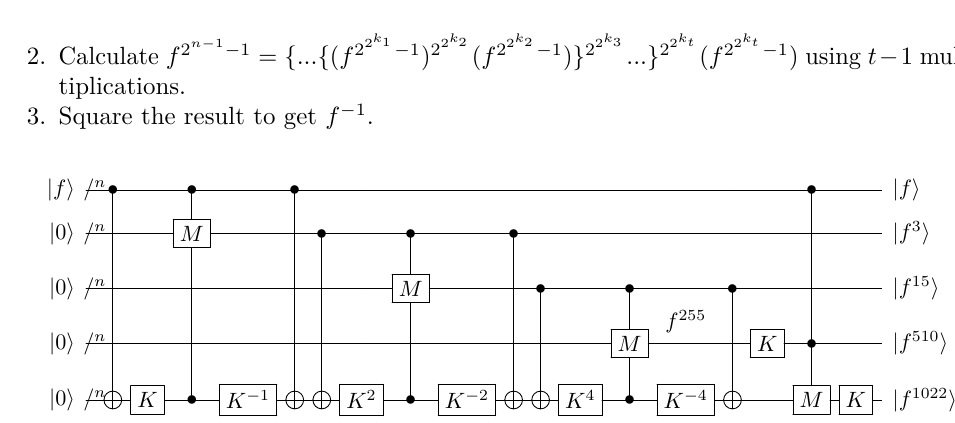
Circuit 6: Step 1-3 of Algorithm 2 for n = 10. K is the squaring circuit using a LUP-decomposition and M is MODMULT. [ k 2 2 3 − 1 = 255.